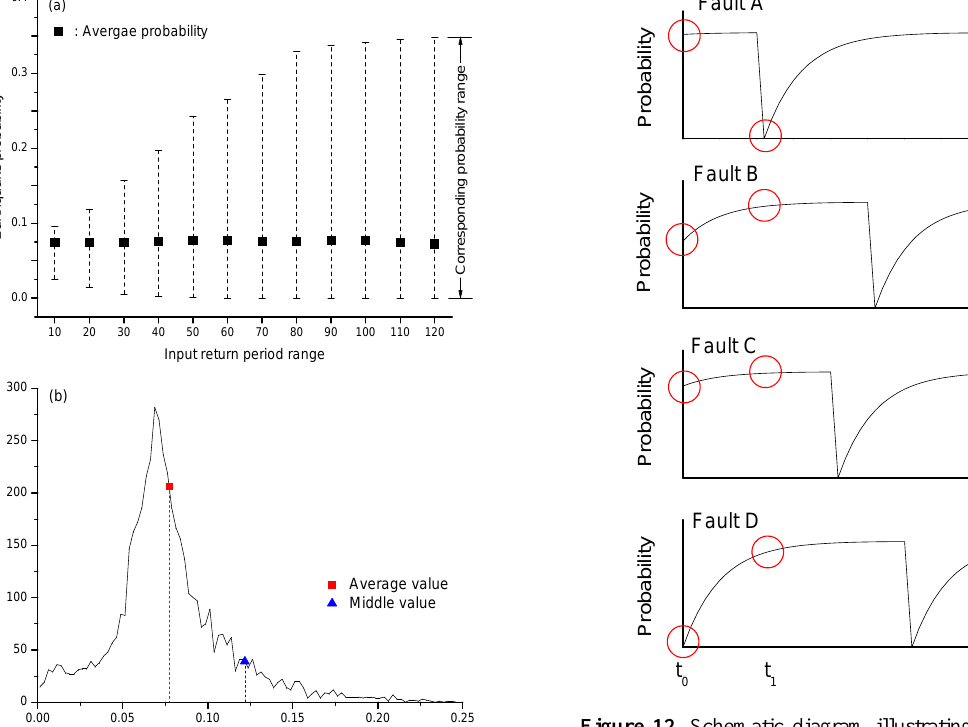
Figure 12. Schematic diagram illustrating the stationary process Fig. 12. Schematic diagram illustrating the stationary process after combining many after combining many non-stationary processes; taking T = t 0 and non-stationary processes; taking T = t 0 and T = t 1 for example, the sum of that many T = t 1 for example, the sum of that many non-stationary probabili- non-stationary probabilities will be close to each other, although the probability is ties will be close to each other, although the probability is very low very low for Fault D at T = t 0 , and it is very low for Fault A at T = t 1 for fault D at T = t 0 , and it is very low for fault A at T = t 1